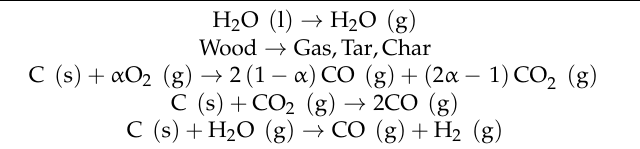
Table 1. Solid phase